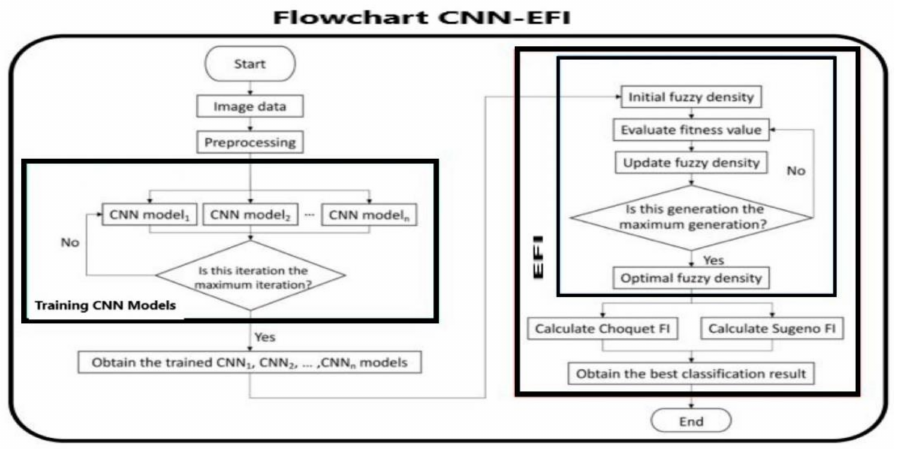
Figure 8. Flowchart of a convolutional neural network (CNN) including an evolutionary-fuzzy- integral routine.